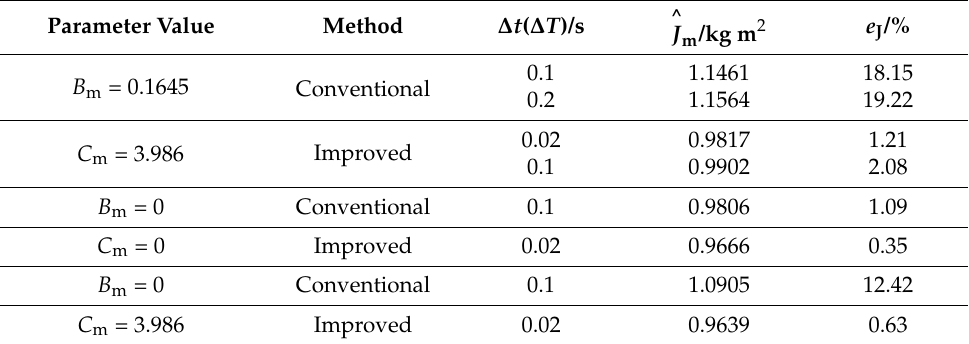
Table 2. Comparison of the simulation results of identification value and identification error. Parameter